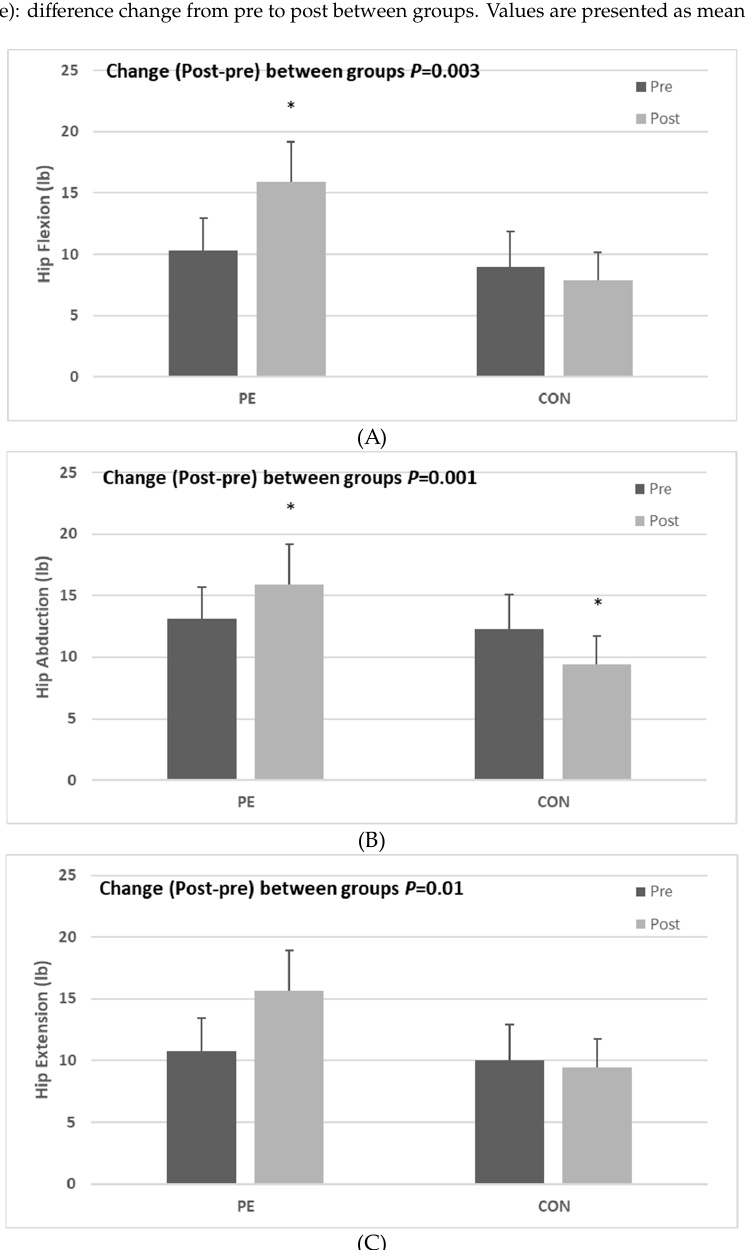
Figure 1. Effect of Pilates exercise on back pain-related muscle strength, ( A ) Hip flexion, ( B ) Hip abduction, and ( C ) Hip extension following 12 weeks of Pilates exercise. Bars represent mean ± SD (PE: n = 9, CON: 7, per group). * p < 0.05 from Pre to Post. PE: Pilates exercise group, CON: control group.